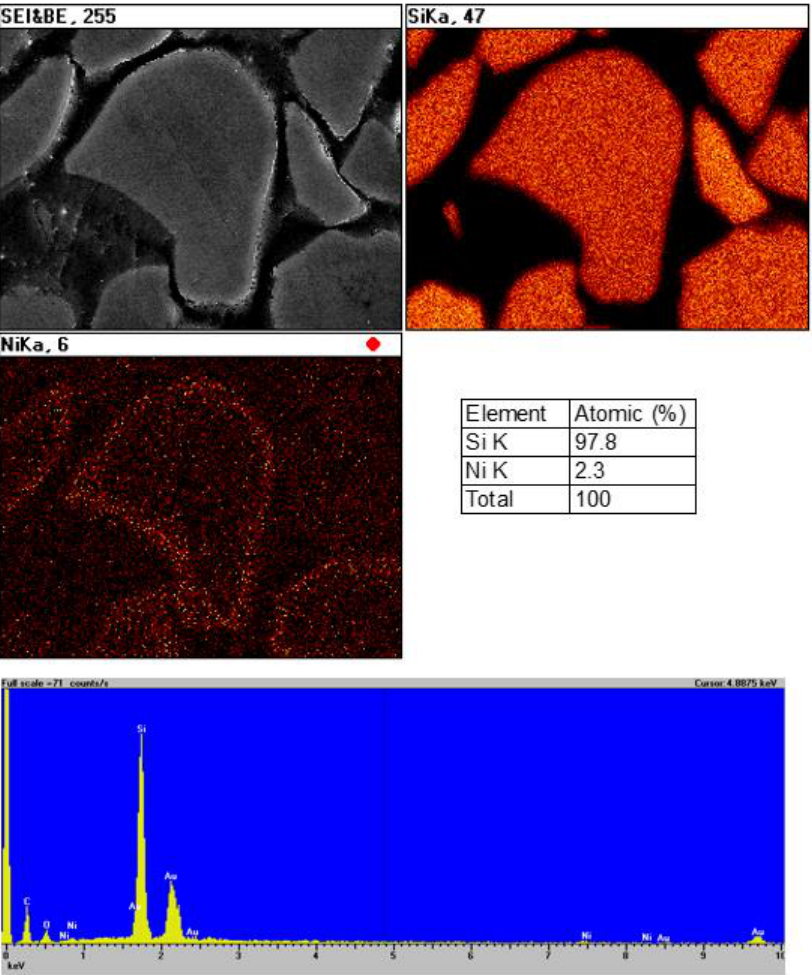
Figure 17. SEM image and EDS elemental mapping of representative Ni-impregnated SiO 2 sample: SiO 2 -CH-Ni-oc-4 (10,000 ppm Ni).